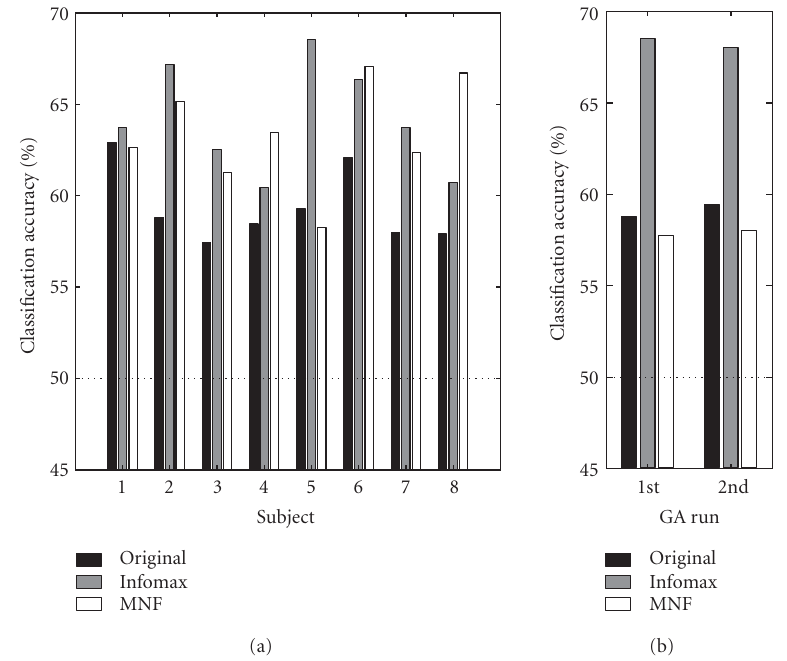
Figure 5: The benefit of the BSS transformations and the replicability of their relative value between GA runs. (a) Mean classification accuracy of the 10 best feature subsets with at least 5 “sample evaluations.” (b) The performance results for the three transformations for subject 5 over two separate runs of the GA.